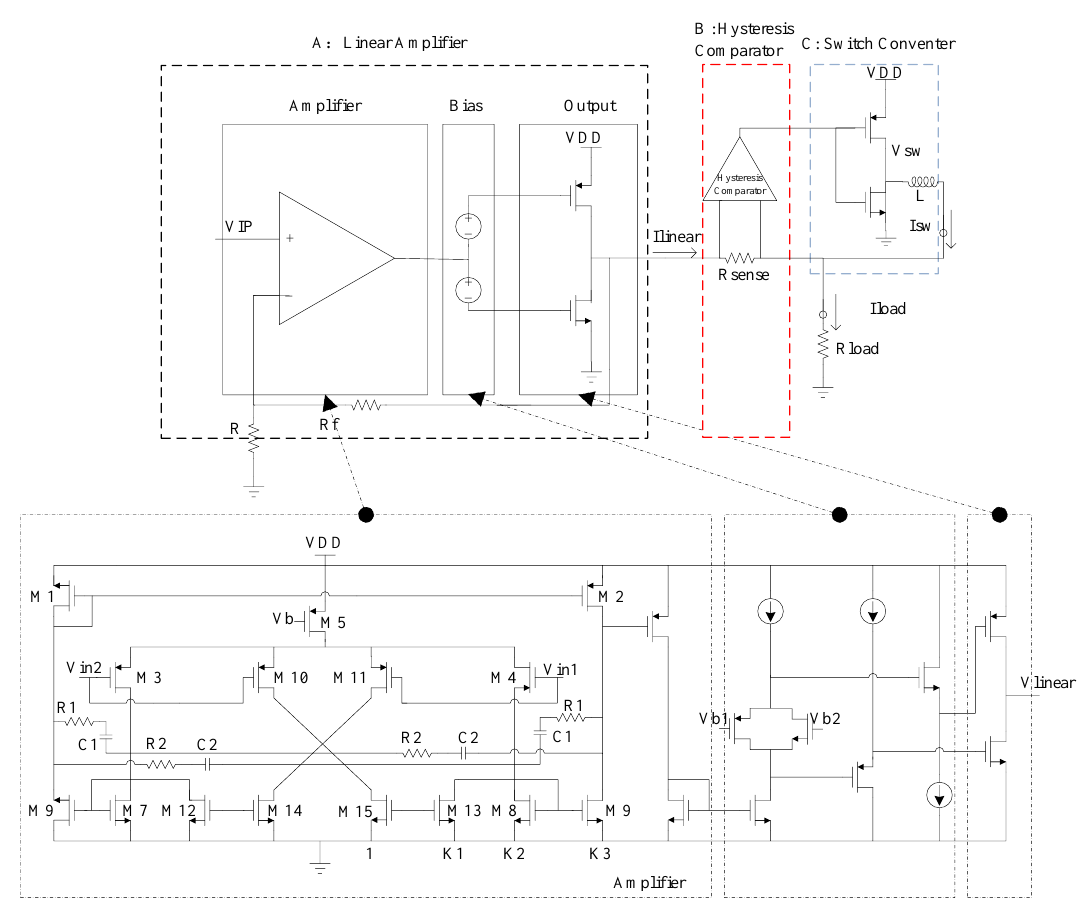
Figure 11. the basic architecture of the hybrid power supply modulator. Figure 11. The basic architecture of the hybrid power supply